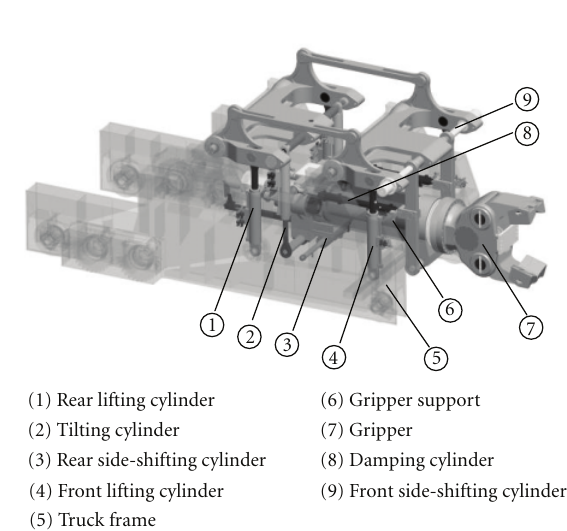
Figure 1: CAD model of the serial-parallel forging manipulator.